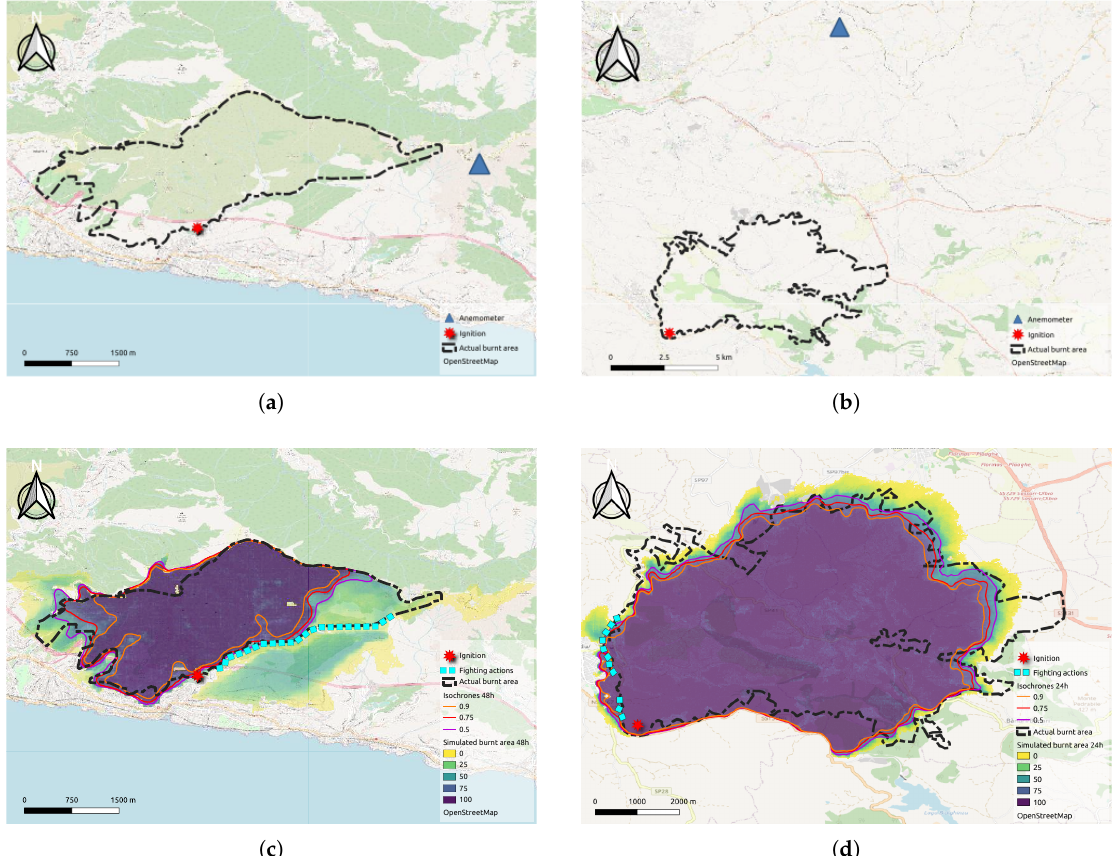
Figure 11. First row: the location of the anemometers used for Fasce Mountain wildfire ( a ) and Ittiri wildfire ( b ) is represented by triangular glyphs. Second row: the two images show actual burnt areas (black dash-dot lines), the ignitions (red stars), the implemented fighting actions (light blue dashed lines), and the simulated burnt areas with their color scale and the isochrones (colored lines) produced at the end of the simulations, which represent the burnt areas with probability higher than 50%, 75%, and 90% for Fasce Moutain ( c ) and Ittiri ( d )